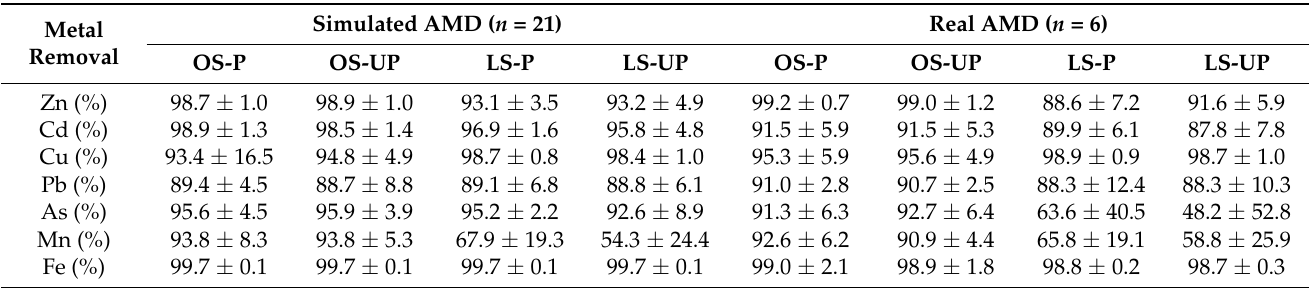
Table 3. Mass removal efficiency (%) of heavy metals from simulated and real AMD using CWs filled